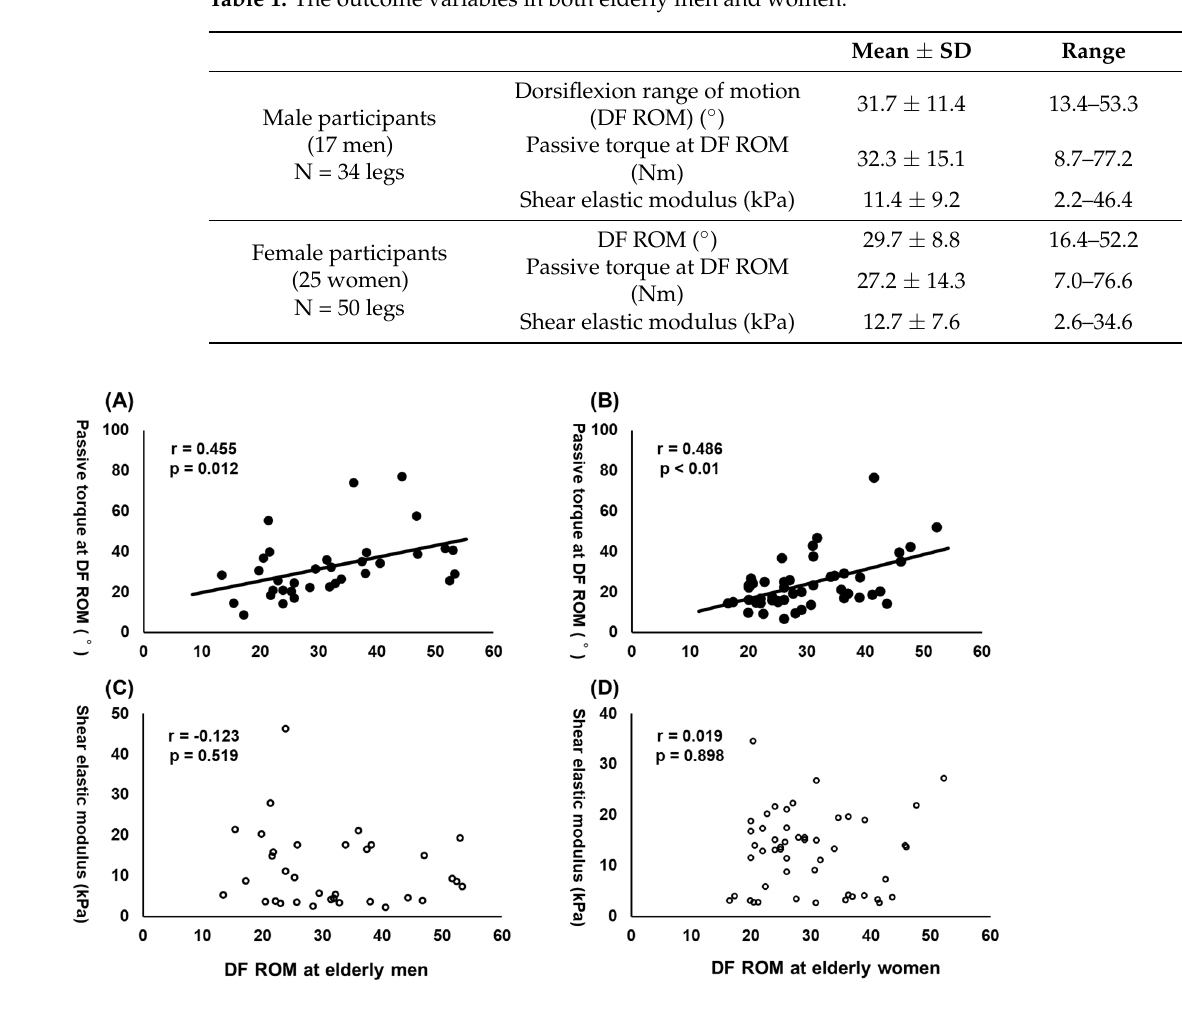
Figure 2. The association between dorsiflexion range of motion (DF ROM) and passive torque at DF ROM ( A : elderly men, B : elderly women) or shear elastic modulus ( C : elderly men, D : elderly women) .